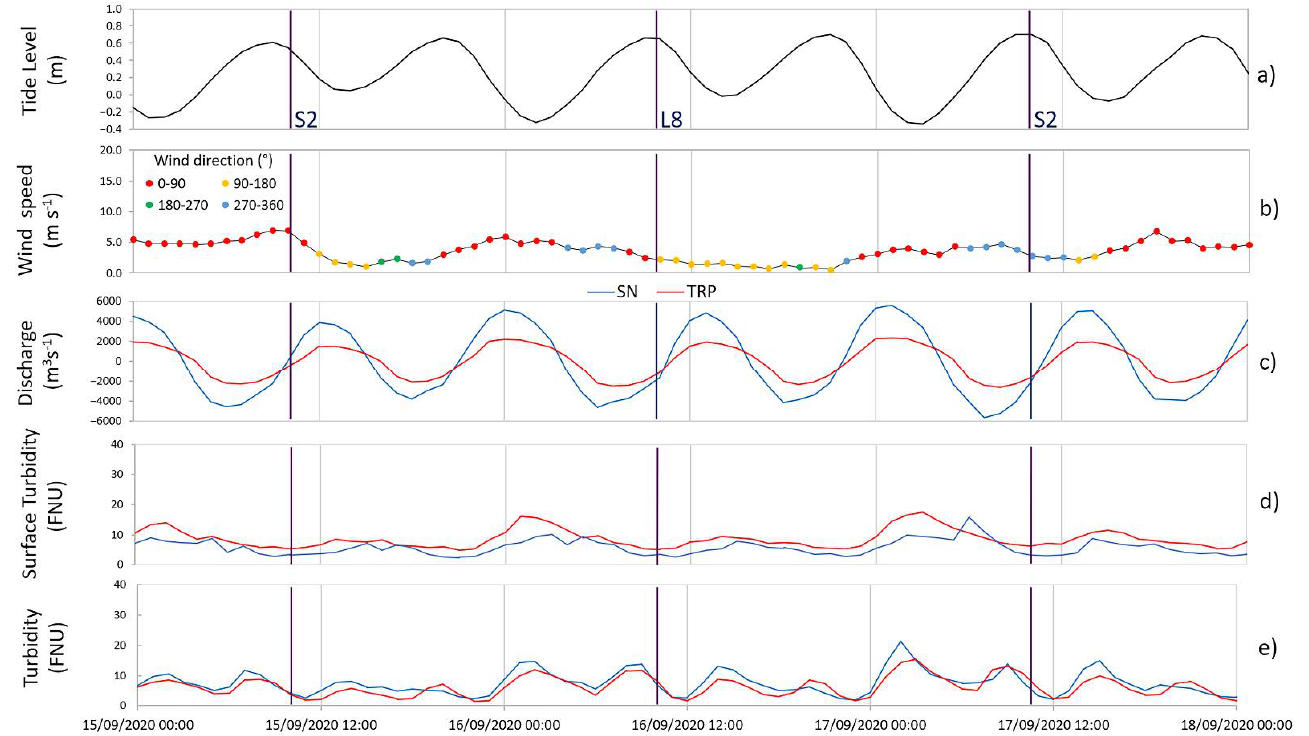
Figure 10. Subset of the time series presented in Figure 7 for the period from 15 to 17 September 2020: tide level measured at Lido Sud meteo-marine station ( a ); wind speed and direction (red = 0 ◦ –90 ◦ , yellow = 90 ◦ –180 ◦ , green = 180 ◦ –270 ◦ , cyan = 270 ◦ –360 ◦ ) ( b ); time series of discharge estimated with the index-velocity method from data of the bottom-mounted ADCPs; positive values of velocity and discharge indicate a seaward flow ( c ); time series of surficial turbidity measured at fixed TRP and SN stations ( d ); and the vertically averaged turbidity derived from the conversion of acoustic backscatter from the bottom-mounted ADCPs ( e ) Vertical blue lines mark the satellites overpass time. S2: Sentinel-2; L8: Landsat